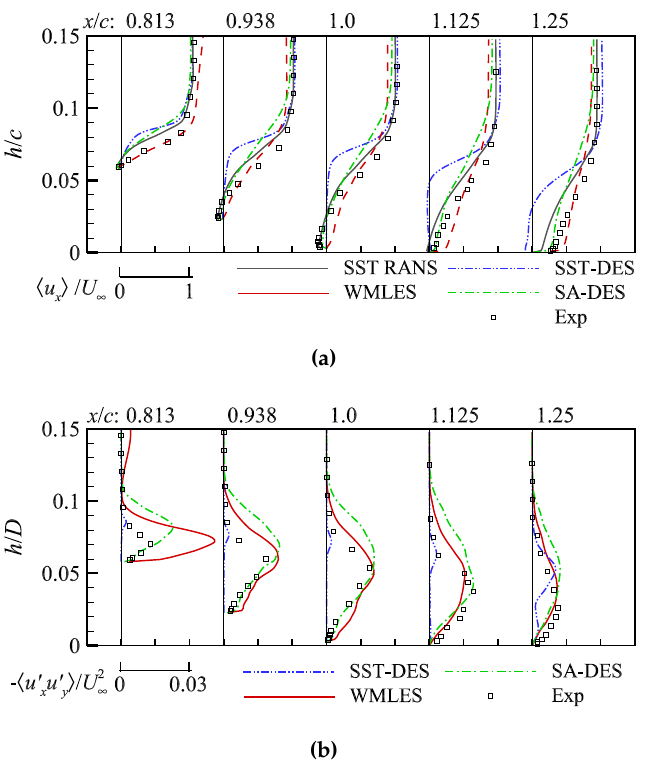
Figure 17. ( a ) Mean streamwise velocity and ( b ) mean resolved Reynolds stress profiles at x / c = 0.813, 0.938, 1.0, 1.125 and 1.25 in the wake region of axisymmetric